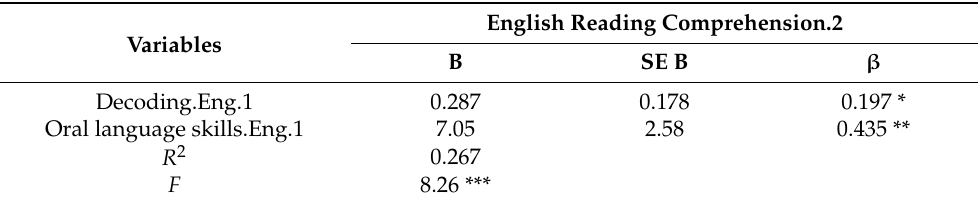
Table 6. Summary of multiple regression analysis for variables predicting monolingual children’s reading comprehension performance in English ( N = 40).